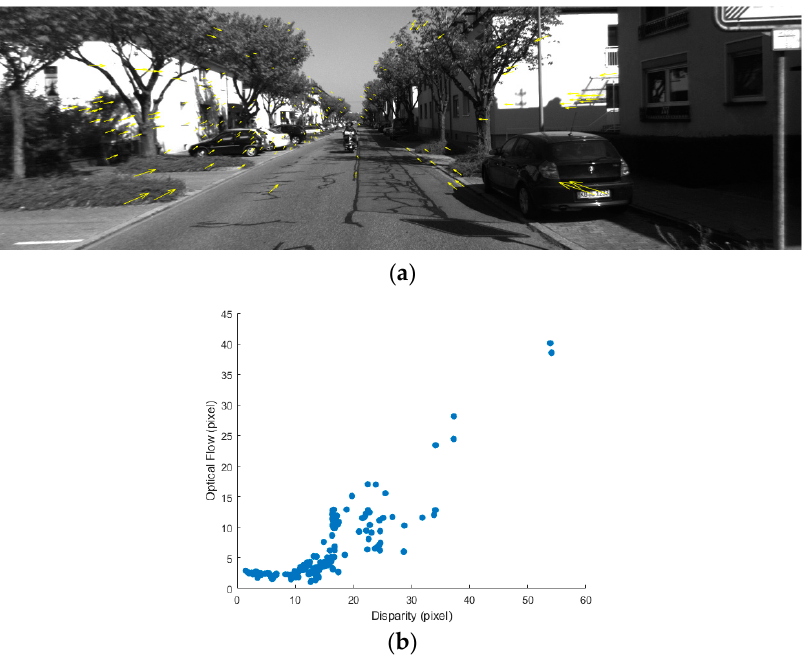
Figure 3. ( a ): Feature point tracking results in frame 0 on sequence 00 of the KITTI odometry dataset. The yellow arrow indicates the optical flow vector of the feature point. ( b ): Relationship between the disparity and the optical flow when the translation velocity is fast and the yaw angle is small; features with a large disparity are prone to large motion and features with a small disparity are prone to small motion. Each blue dot corresponds to a feature point in ( a ).